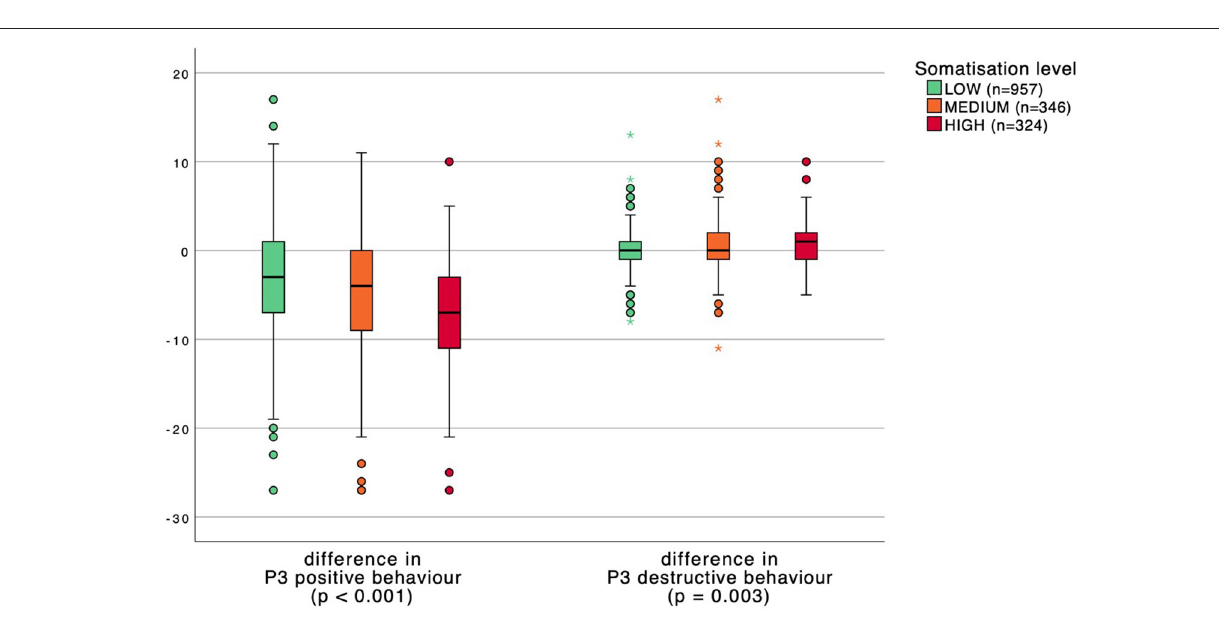
but the positive behavior score decreased greatly compared with other